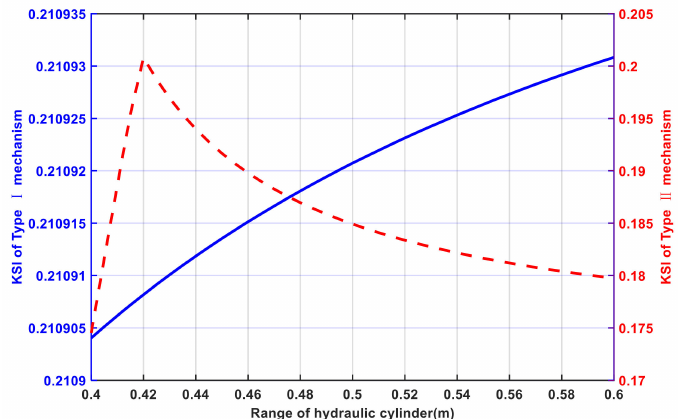
Figure 13. KSI variation caused by a range of hydraulic cylinder. The blue solid line stands for index of type I mechanism, the red dashed line stands for index of type II